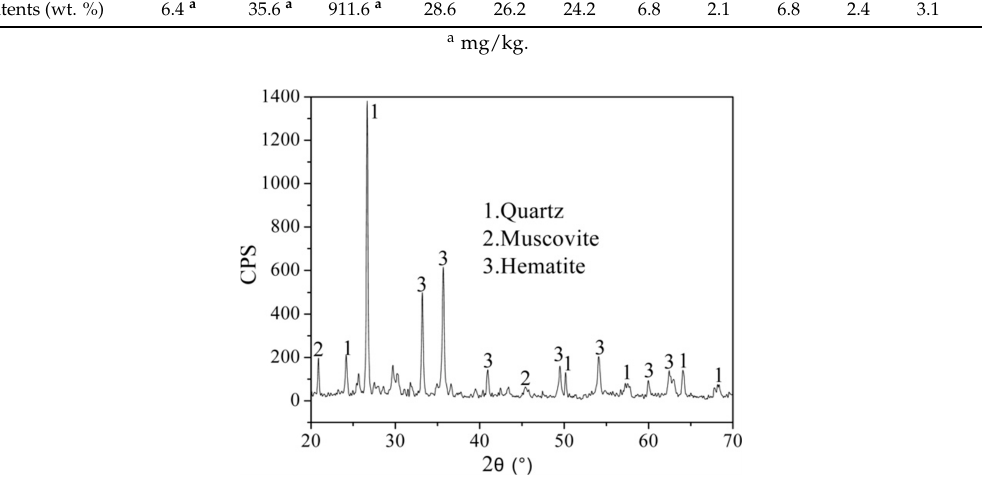
Table 2. XRF and AAS analysis for the ore sample from near-surface oxide zone in Moisan Gold deposit (Haenam, South Korea). The contents of the target elements such as Au, Ag, As and total Fe were analyzed using AAS. The mineral compositions were determined XRF analysis. Element/Mineral Au Ag As T Fe Contents (wt. %)